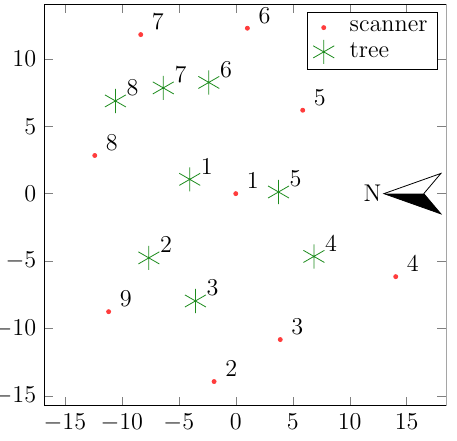
Figure 15. Scanner and tree locations. The scale is in